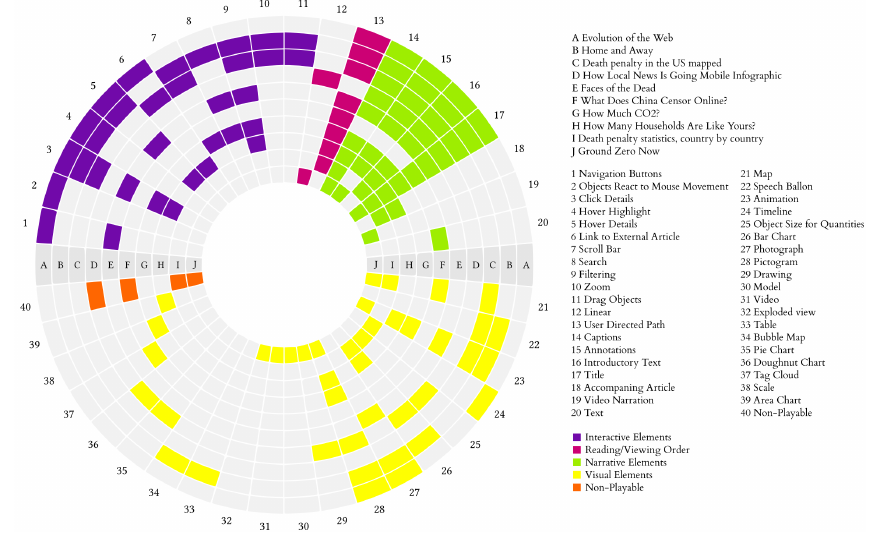
Figure 18. Figueiras shows the visualizations used in the focus group study and the elements that compose them [28]. Image courtesy of Figueiras et al.